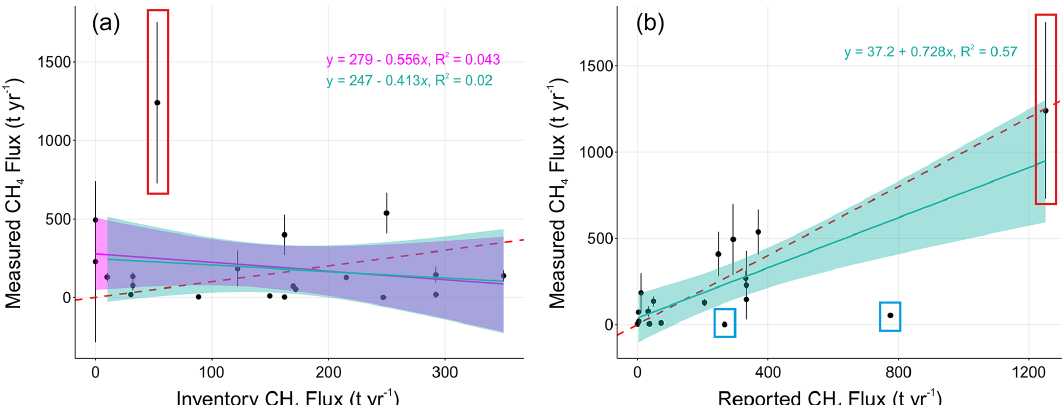
Figure 4. Comparison of measured CH 4 emission fluxes and (a) corresponding estimates from the Scarpelli et al. (2020) global inventory and (b) corresponding operator-reported emissions for each facility. The data point in the red box represents a particularly high measured flux of 1239.65tyr − 1 . The data points in the blue boxes in panel (b) represent the two facilities which do not fit with the general pattern, with near-zero measured fluxes. The green line represents a fitted linear regression through all data points, and the magenta line represents a fitted regression which excludes inventory or reported emissions of zero. This magenta line is not shown in panel (b) , as the two regression lines were essentially identical. The font colours of the equations shown correspond to the colour of the respective regression line. The shaded regions of these lines correspond to the 95% confidence levels for the slopes. The red dashed line shows the 1 : 1 correspondence line for